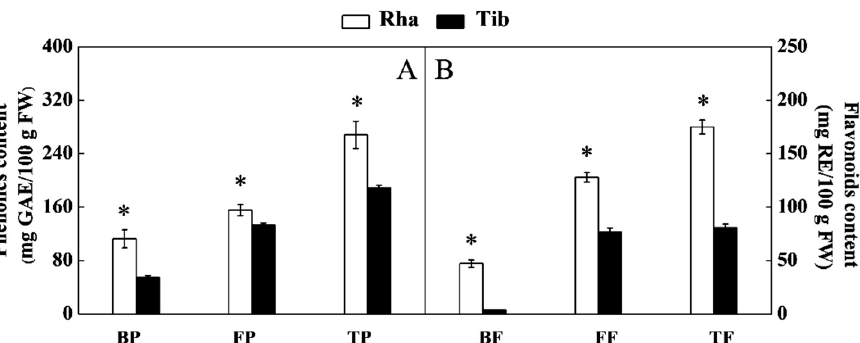
Figure 3. The content of phenolics ( A ) and flavonoids ( B ) in Rha and Tib berries. Vertical bars represent standard error of the mean ( ± SE), and the “*” indicate significant differences at p < 0.05. BP, bound phenolics; FP, free phenolics; TP, total phenolics; BF, bound flavonoids; FF, free flavonoids; TF, total flavonoids. ( A ) The content of phenolics in Rha and Tib berries; ( B ) The content of flavonoids in Rha and Tib berries.